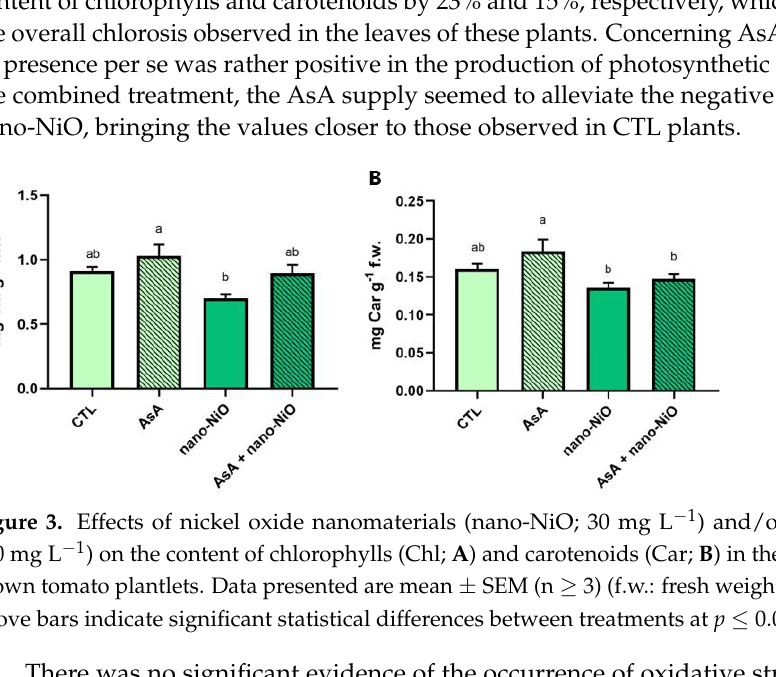
Figure 2. Macroscopic effects of nickel oxide nanomaterials (nano-NiO; 30 mg L −1 ) and/or ascorbate (AsA; 150 mg L −1 ) on the growth and development of in vitro grown tomato plantlets.